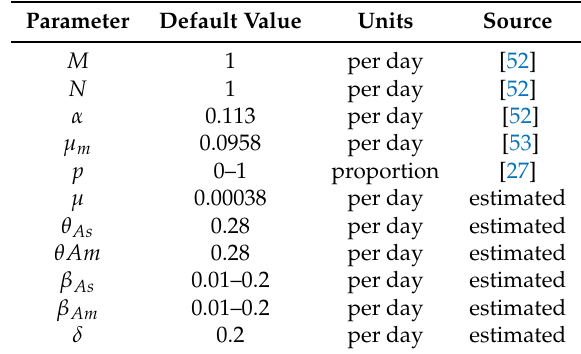
Table 1. Default Parameter Values: Biological parameters may vary across geographic and temporal scales, however, most of the values are taken from related literature or estimated to achieve the desired reproductive number.